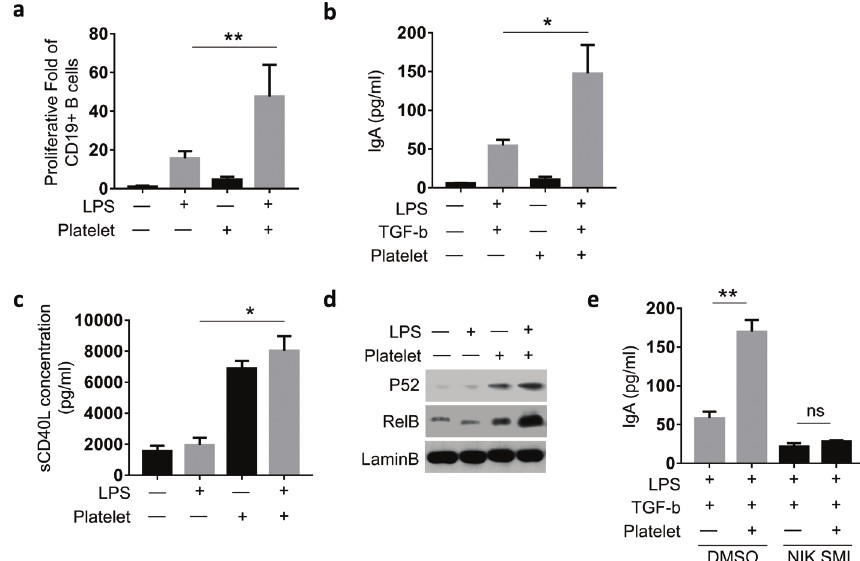
Fig. 4 . Platelets promoted IgA induction in B cells via regulating non-canonical NF- κ B. (a) Splenic B cells were stimulated for 48 h either in the absence or presence of LPS (100 ng/mL) plus 1:1 the supernatant of platelets. Cell proliferation assays of splenic T cells were evaluated by CCK8. (b) Splenic B cells were cultured for 5 days in the presence of 1 μg/mL LPS alone or in combination with 2 ng/mL TGF- β or the supernatant (1:1). IgA in cells supernatants was evaluated by ELISA. (c) The protein level of secreted CD40L in the supernatant of B cells stimulated for 48 h with of LPS (100 ng/mL) plus 1:1 the supernatant of platelets by ELISA. (d) Westernb blot analysis of non-canonical NF- κ B signal in the nuclear extract of B cells treated as indicated. (e) Splenic B cells were treated as indicated plus NIK inhibitor (0.5 nM). IgA in supernatants of the cells was evaluated by ELISA. The data were expressed as means ± standard error of mean (SEM). Results represent the mean values of three independent experiments. *, P < 0.05; **, P <